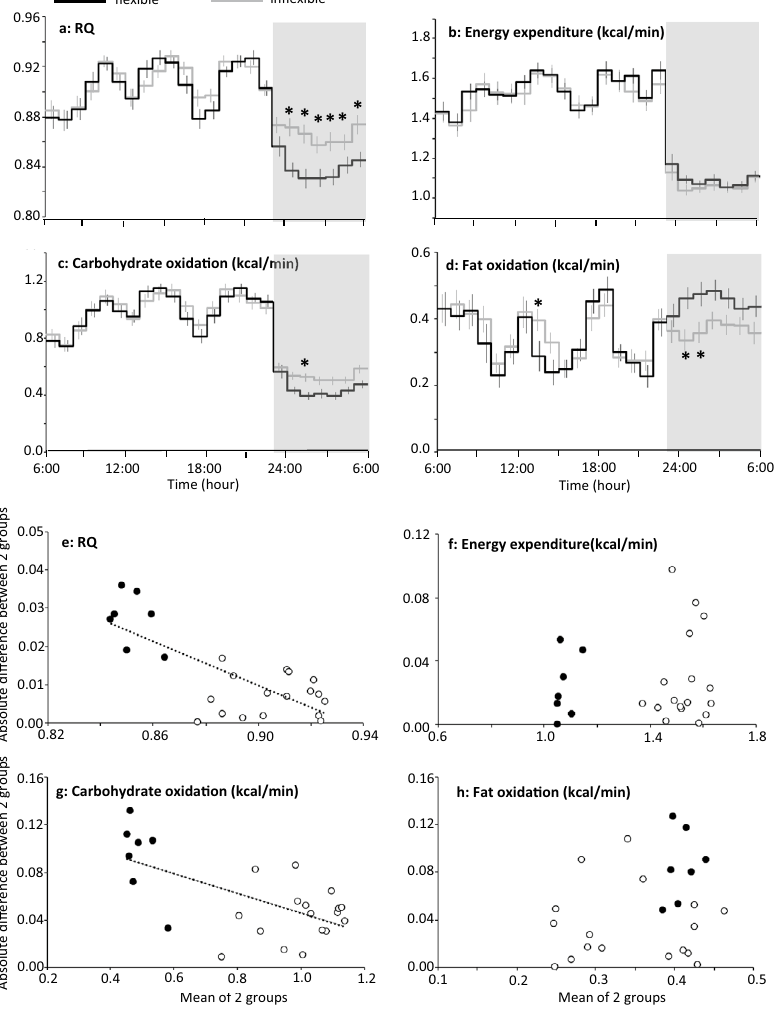
Figure 2. 24 h profile of energy metabolism in metabolically flexible and inflexible subjects. ( a – d ) Forty-one young men were grouped as metabolically flexible (n = 20) or inflexible (n = 21) according to the magnitude of range of RQ over the 24 h 19–22 . Subjects took breakfast (7:00 or 9:00), lunch (12:00, 12:30 or 13:00), and dinner (18:00), and slept for 7 h (23:00–06:00, grey bars). Mean ± SE of RQ, energy expenditure, carbohydrate oxidation and fat oxidation were shown for metabolically flexible (black lines) and inflexible (grey lines) group. A linear mixed-models ANOVA showed a significant effect of time (P < 0.01) and a group × time interaction (P < 0.01) but main effect of group was not significant for RQ (P = 0.145), carbohydrate oxidation (P = 0.420) and fat oxidation (P = 0.731). For energy expenditure, effect of time was significant (P < 0.01) but main effect of group (P = 0.726) and group × time interaction (P = 0.170) was not significant. *Represents significant difference between the 2 subgroups by post hoc pair-wise comparisons (P < 0.05). ( e – h ) Absolute differences between metabolically flexible and inflexible subgroup were plotted against mean of the two subgroups for RQ, energy expenditure, carbohydrate oxidation and fat oxidation. Values during sleep were shown as filled symbols (filled black circles). Significant negative correlation between absolute difference and mean of the two subgroups was observed in RQ and carbohydrate oxidation (P <